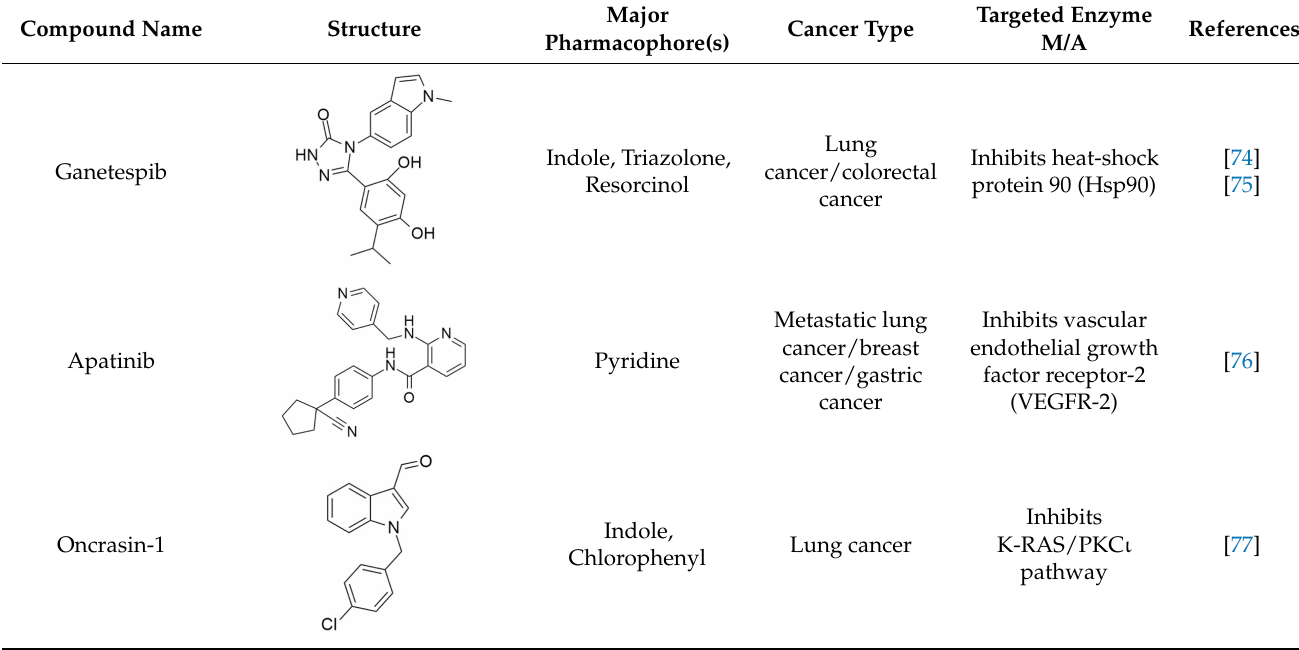
Table 1. Aza heterocyclic small-molecule RAS inhibitors with one nitrogen